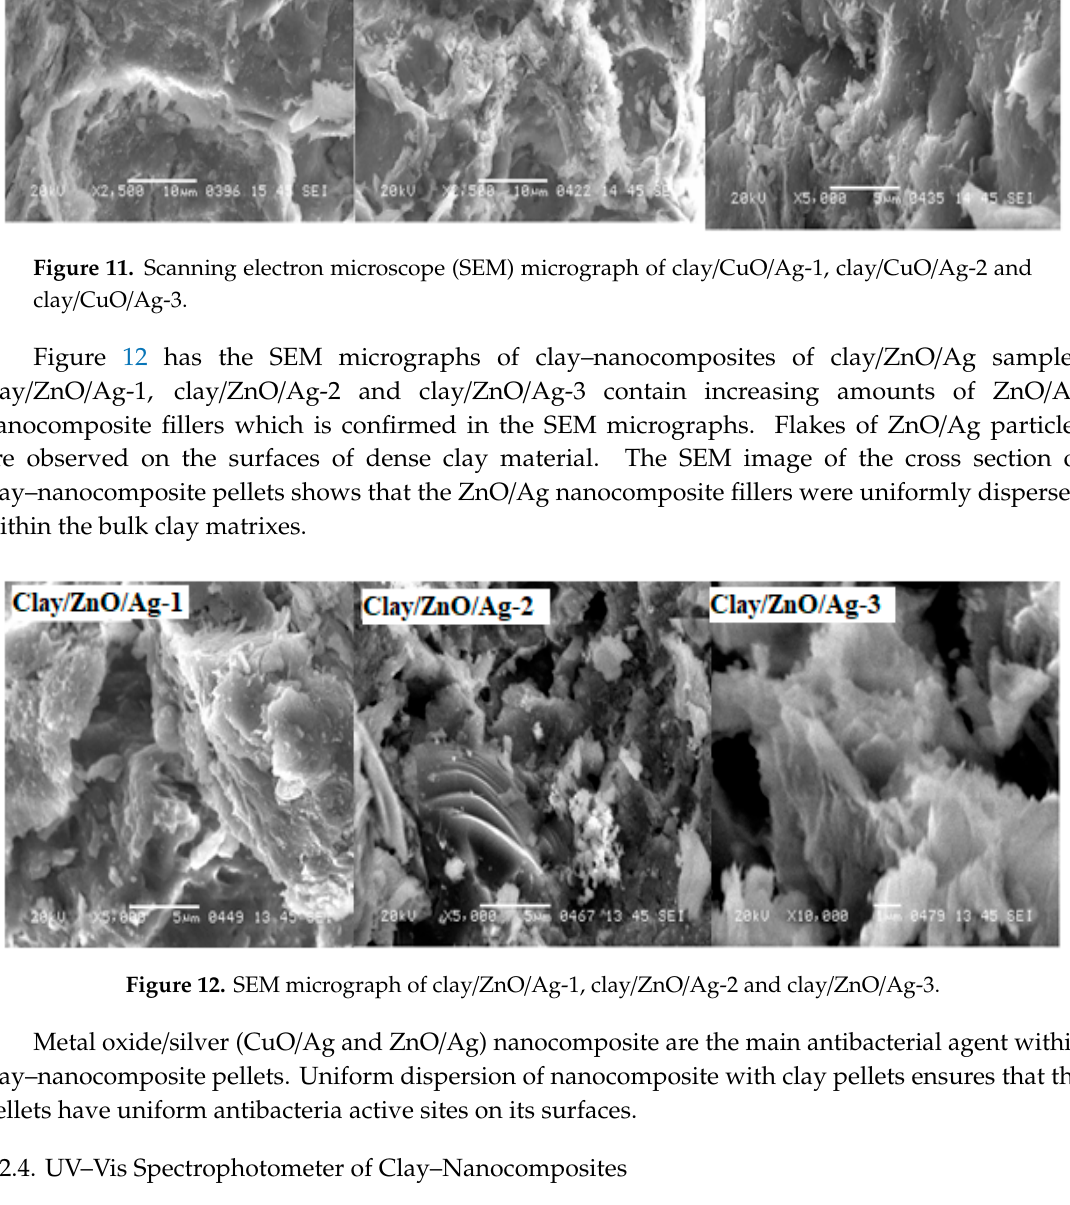
Figure 12. SEM micrograph of clay/ZnO/Ag-1, clay/ZnO/Ag-2 and clay/ZnO/Ag-3.